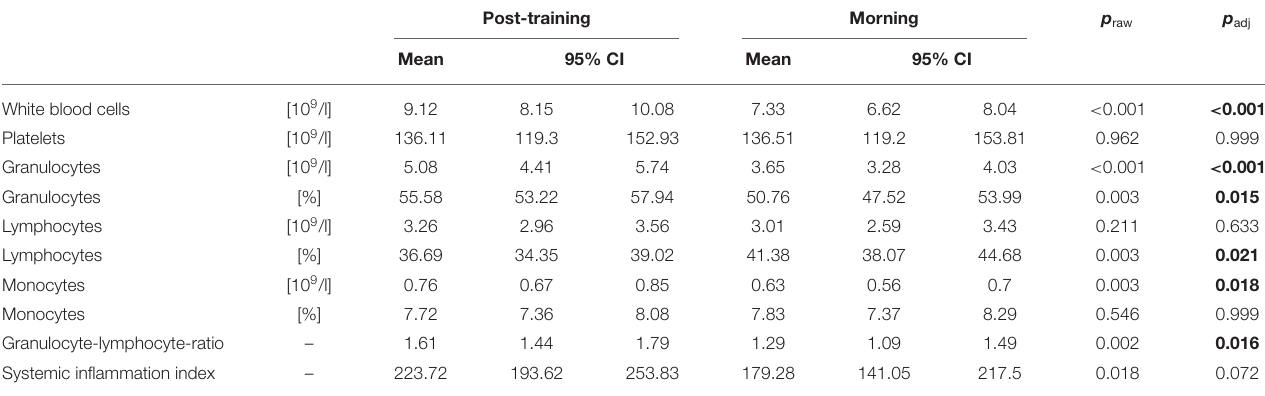
TABLE 1 | Marginal means and confidence intervals (95% CI) resulting from generalized estimating equation models for capillary immunological blood markers. Post-training Morning p